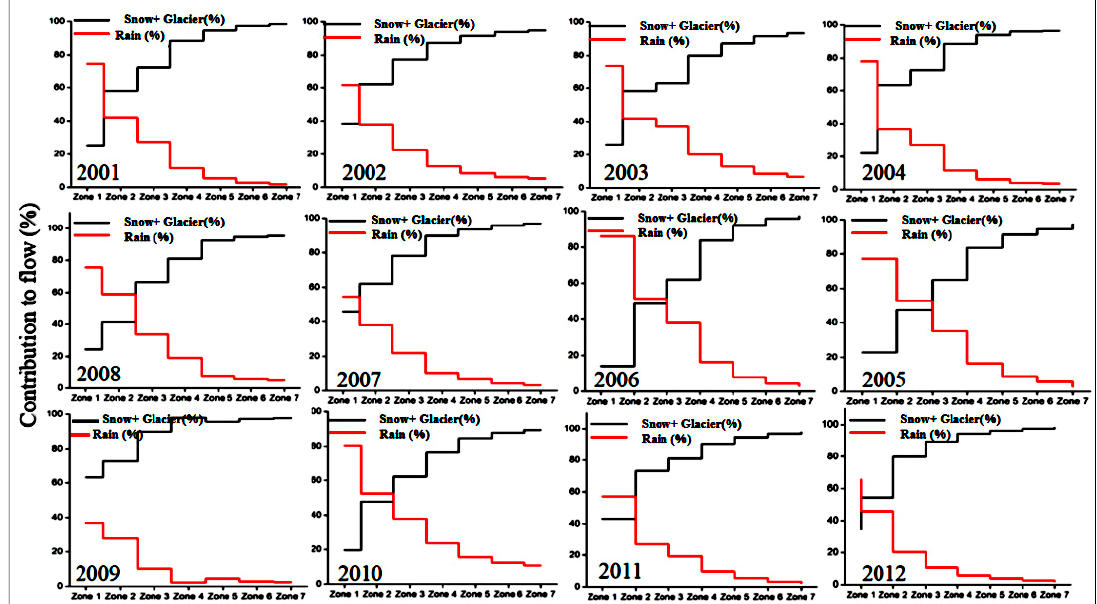
Figure 8. Zone-wise cumulative rain and snow and glacier melt contributions (%) to flow calculated by SRM over the simulation period 2001–2012.